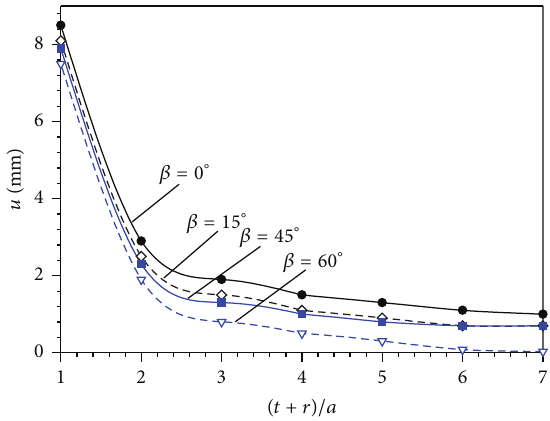
Figure 10: The displacement varies with distance.